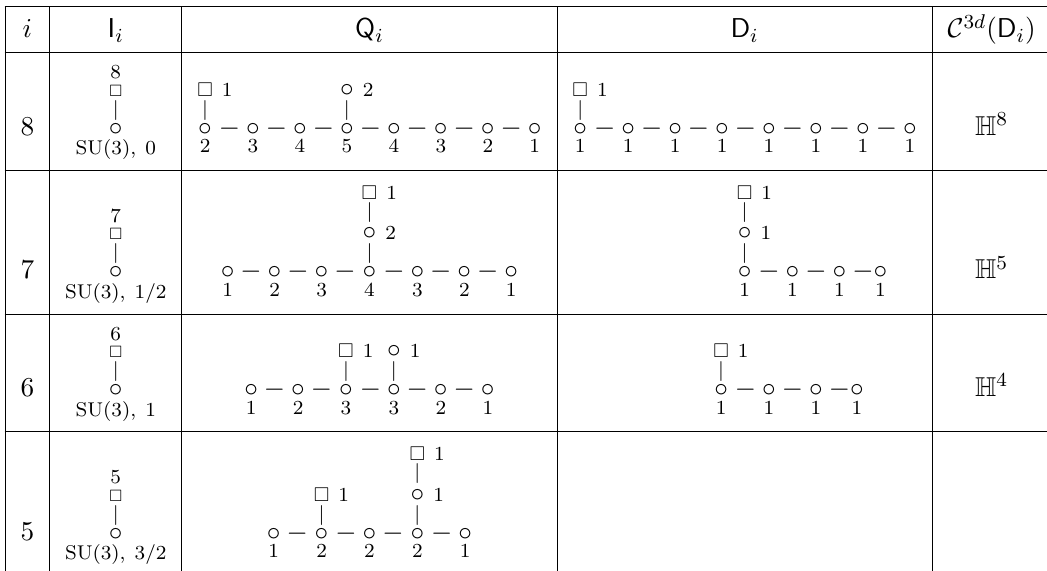
Table 3 . Quiver di(cid:11)erences between Higgs branches of 5 d theories at in(cid:12)nite coupling. I i are 5 d quivers. Q i are 3 d quivers such that H 1 ( I i ) = C 3 d ( Q i ) [41]. On the right, the quiver subtractions have been computed D i = Q i (cid:0) Q i (cid:0) 1